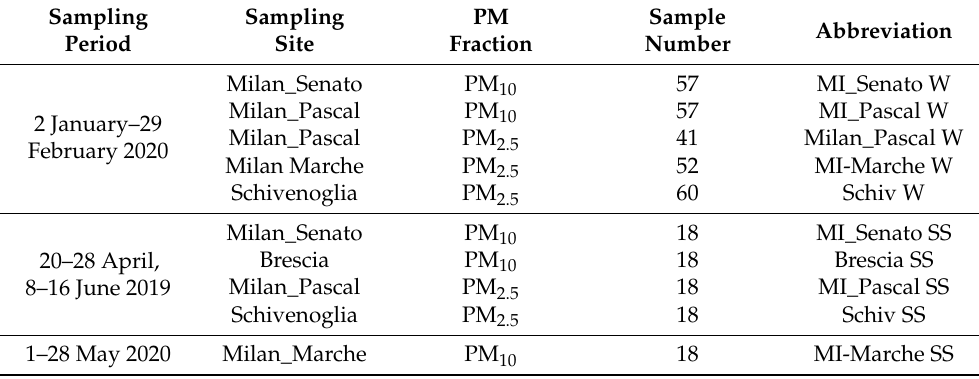
Table 1. Description of the studied samples: sampling period, site location, PM size fraction and number of collected filters for each sampling